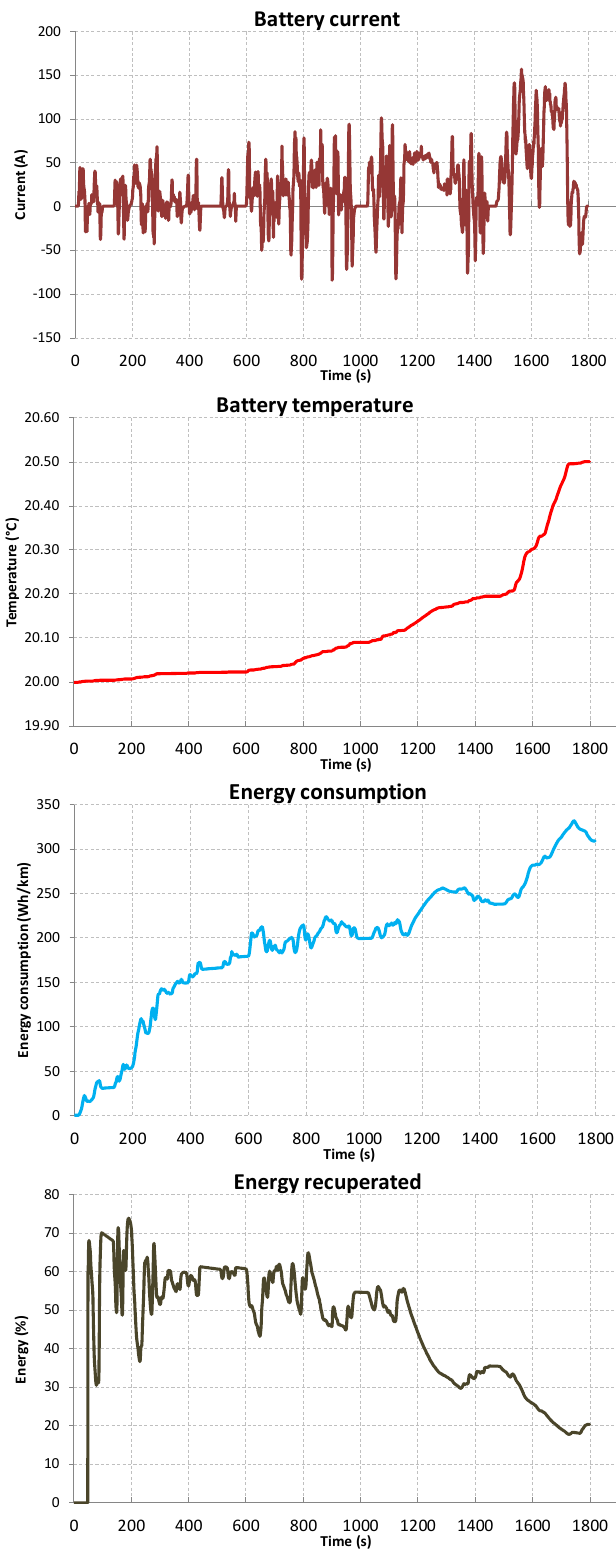
Figure 13. WLTC 3b-results of simulation tests for the 4 × 2 drive system.